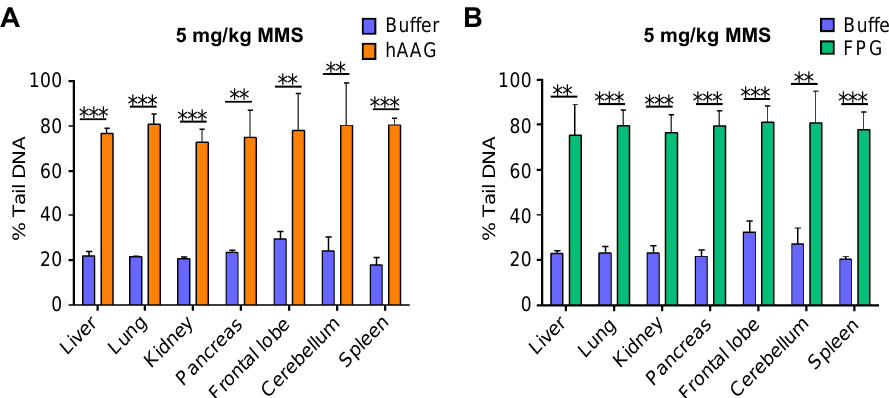
Figure 3. MMS-induced base lesions can be detected by the CometChip. Tissues from mice exposed to 5 mg/kg of MMS were analyzed with enzyme-modified alkaline CometChip. Results show DNA damage in various tissues using the CometChip modified by addition of ( A ) hAAG enzyme or hAAG buffer and ( B ) Fpg enzyme or Fpg buffer. Percent tail in DNA represented as mean of three mice ± SD. Unpaired Student’s t -test, ** p < 0.01, *** p < 0.001.